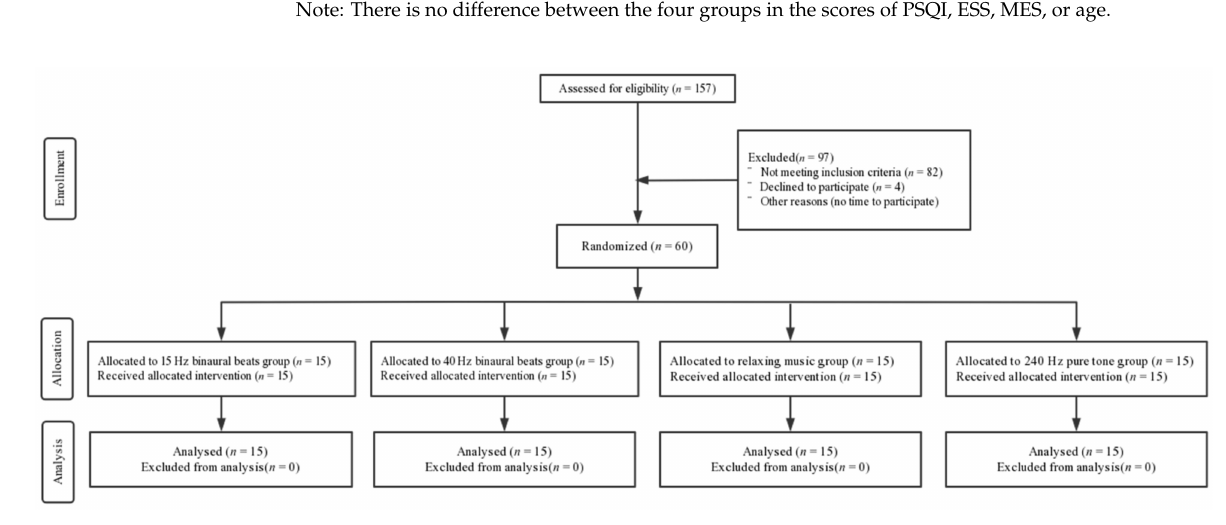
Figure 1. CONSORT flow